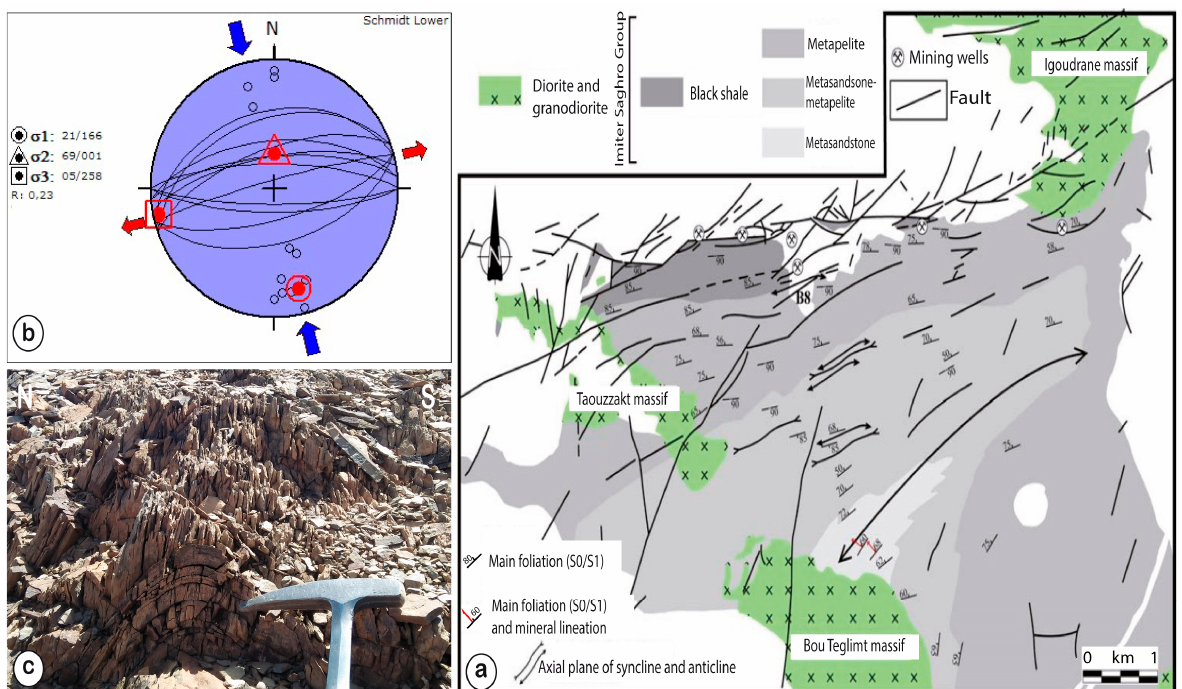
Figure 3. ( a ) Structural map of Imiter’s basement, showing foliation and fold orientation at the map scale; ( b ) stereographic projection of foliation planes, poles, and poles density; ( c ) photograph of an upright foliation fold which affecting the metasediments of the Saghro Group.